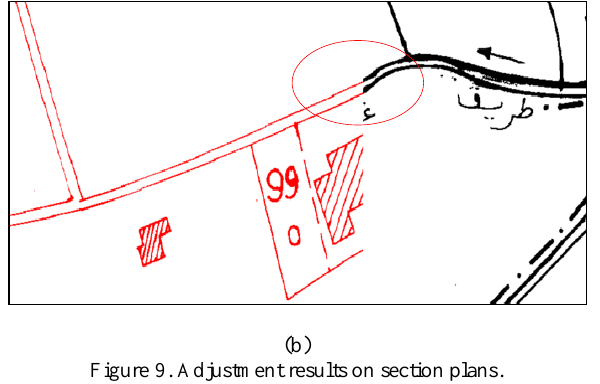
Figure 9. Adjustment results on section plans.